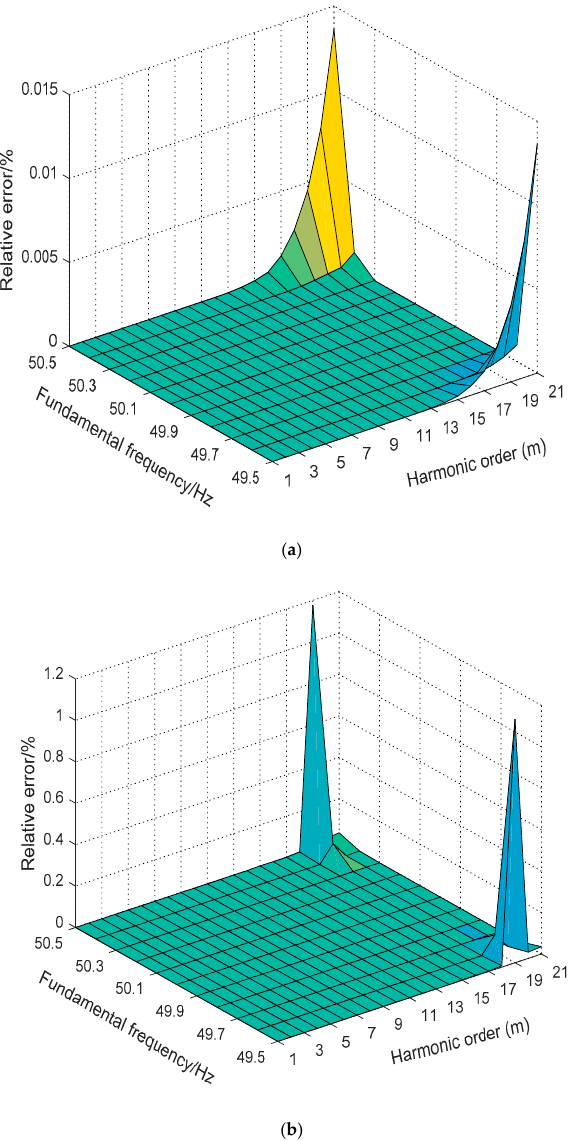
Figure 5. Measurement error of the Nuttall window. ( a ) Amplitude relative error and ( b ) phase relative error.